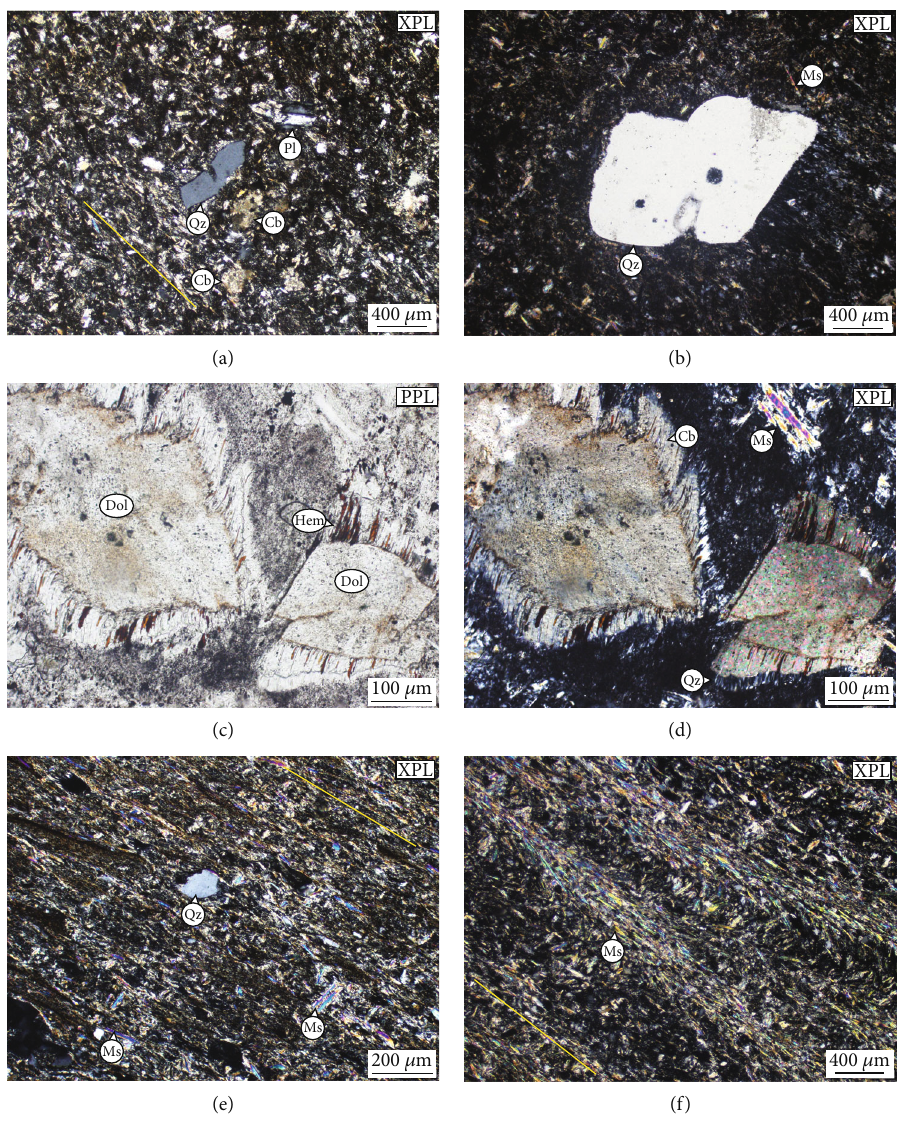
Figure 6: Thin-section photomicrographs of the Permian siliciclastic rocks ((a – d) well Kel – 12 core #3; (e, f) well Kel – 14 core #3). (a) Broken quartz and plagioclase crystals in the fi ne-grained matrix showing a weakly developed foliation (yellow line). Note: selective carbonatization of the matrix material. (b) A broken resorbed crystal of volcanic quartz. (c, d) Strain fringes around saddle dolomite core objects which show sweeping extinction. (e, f) Domainal spaced cleavage (foliation is indicated by the yellow line) with quartz and muscovite stacks in microlithons. Abbreviations: PPL: plane-polarized light; XPL: cross-polarized light; Cb: carbonate; Dol: dolomite; Hem: hematite; Ms: muscovite (detrital); Pl: plagioclase; Qz: